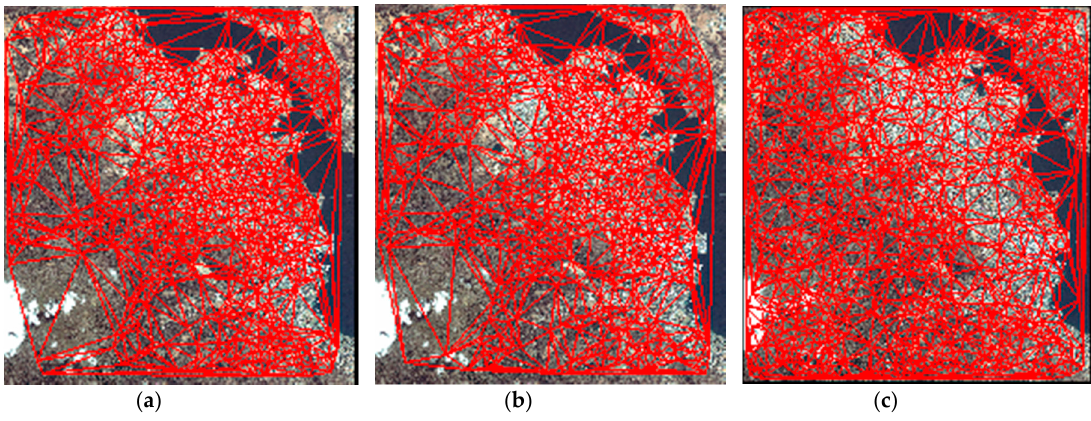
Figure 10. Matching result on Dataset 1. ( a ) CMPs with TIN by Lee’s method. ( b ) CMPs with TIN by Li’s method. ( c ) CMPs with TIN by the proposed method.